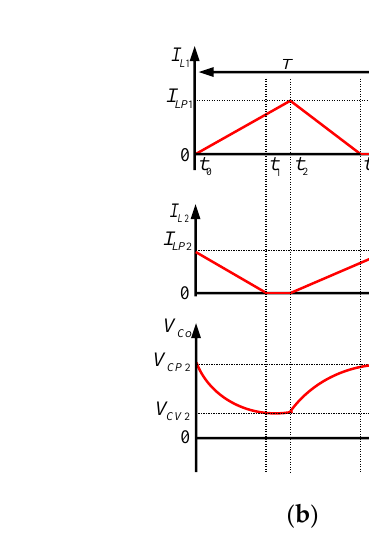
Figure 3. Some key waveforms of the proposed topology; ( a ) at CCM, ( b ) at DCM. Here, some critical relations of the proposed converter are illustrated. The first index shows the component number and second part is used for time intervals, whereas 1 and 2 show T on and T of f in CCM, respectively, and 1, 2, 3, and 4 show ( t 0 , t 1 ) , ( t 1 , t 2 ) , ( t 2 , t 3 ) , and ( t 3 , t 4 ) at DCM,